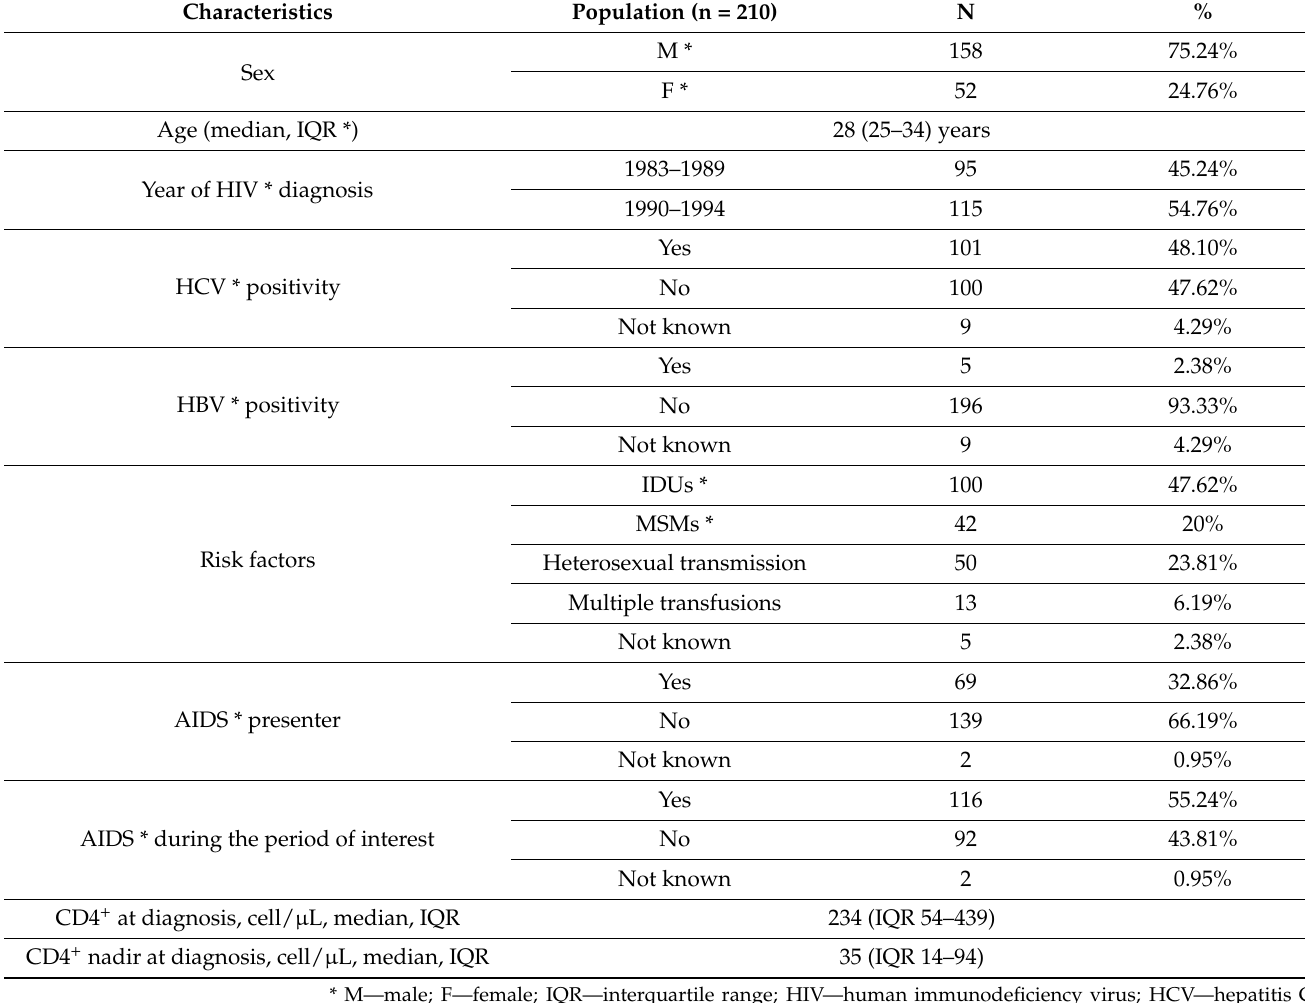
Table 1. Clinical and epidemiological characteristics of the whole